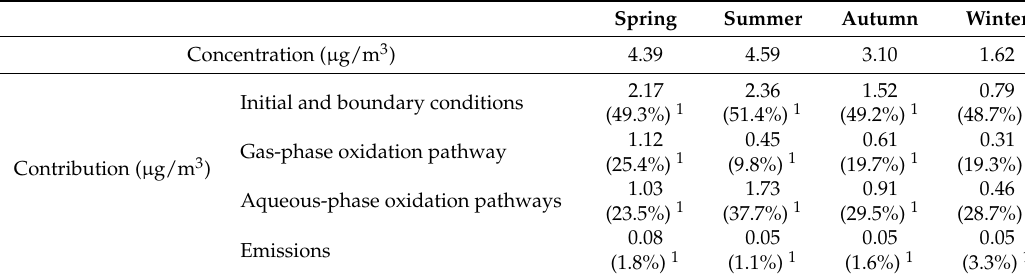
Figure 4. Spatial distributions of ( a ) contributions from initial and boundary conditions, ( b ) contribution from the gas-phase oxidation pathway, and ( c ) contributions from the aqueous-phase oxidation pathways averaged over ( i ) spring, ( ii ) summer, ( iii ) autumn, and ( iv ) winter. Model results are from the base-case simulation with STM. Table 2. Domain-averaged concentration of SO 42 and each contribution estimated by STM.